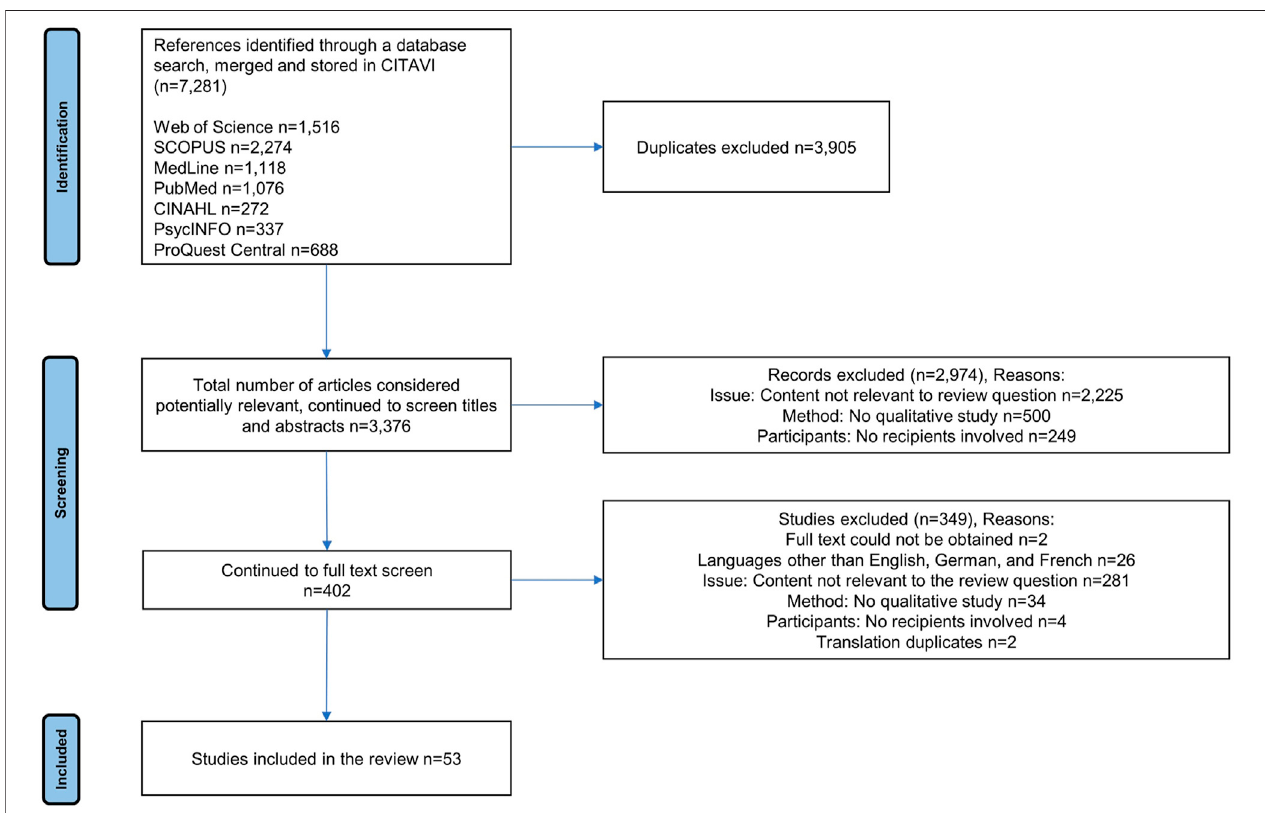
FIGURE 1 | PRISMA fl ow chart of the literature search and screening